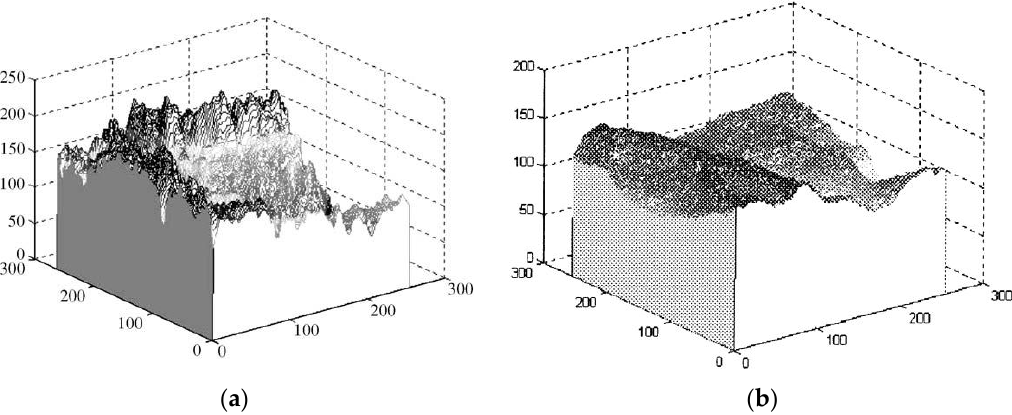
Figure 9. 3D profile of palmprint and vein pattern ROIs. The vertical axis represents the gray level of pixels. The other two axes represent the coordinates of pixels. ( a ) The profile of the palmprint ROI shows a sudden change in the gray levels of adjacent pixels near the principal palmprint, which possesses high frequency; ( b ) The vein pattern profile demonstrates that the gray levels of the vein pattern vary smoothly. The vein pattern has a low frequency.